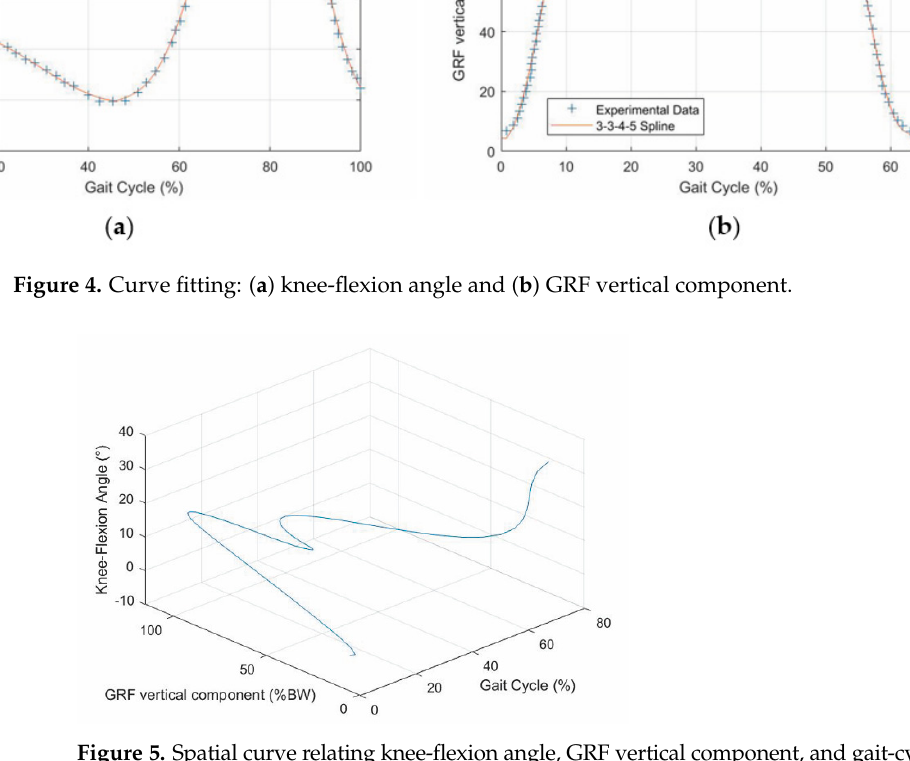
Figure 5. Spatial curve relating knee-flexion angle, GRF vertical component, and gait-cycle per- centage.